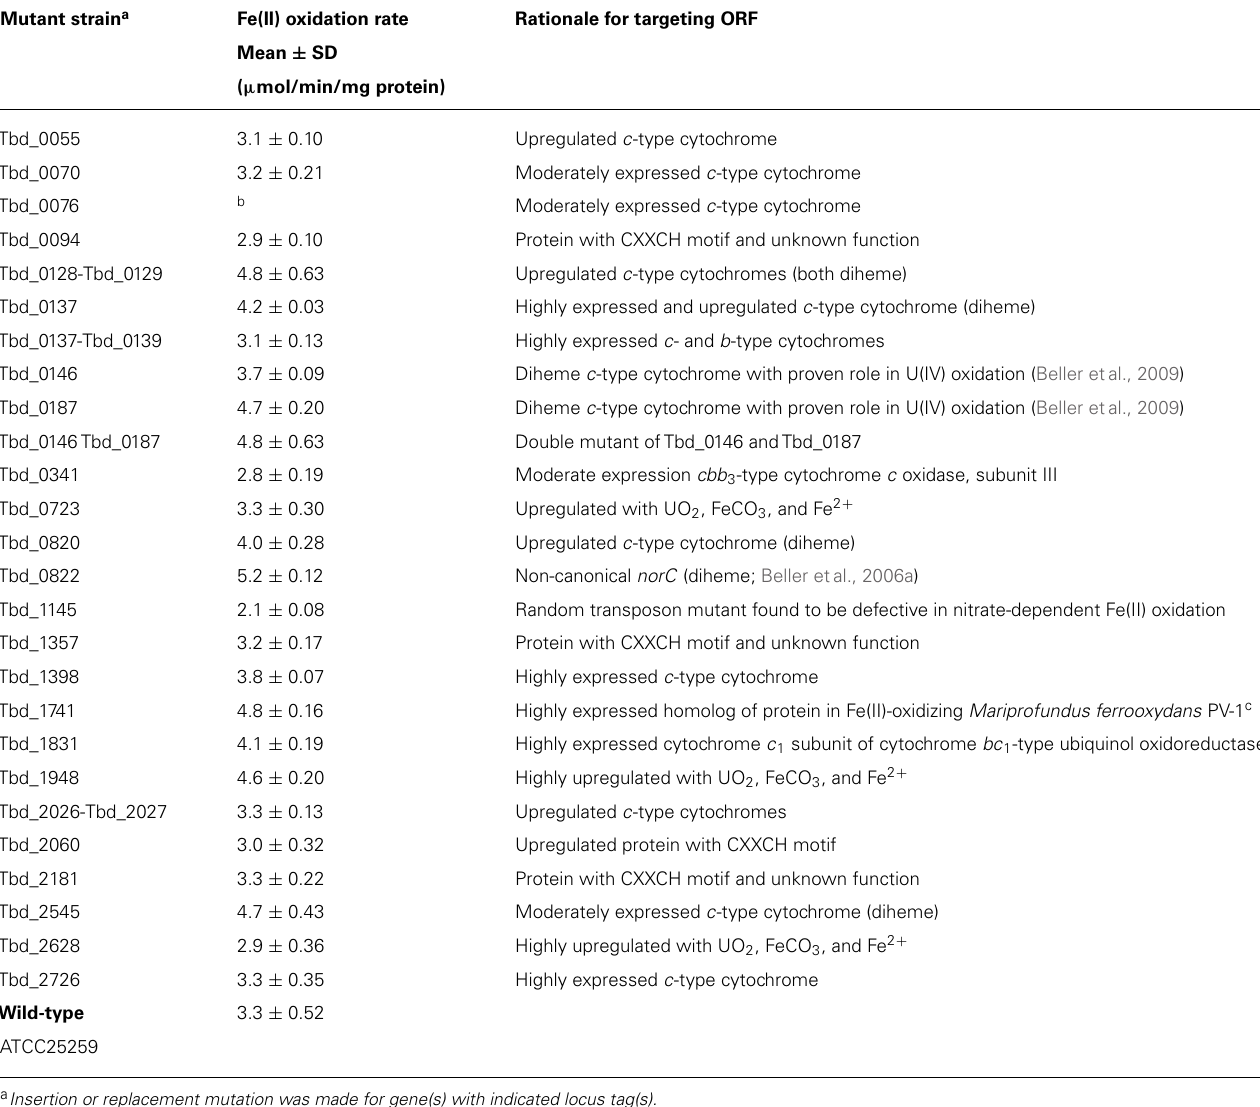
Table 4 | Specific rates of nitrate-dependent Fe(II) oxidation by T. denitrificans wild-type and mutants under study. Mutant strain a Fe(II) oxidation